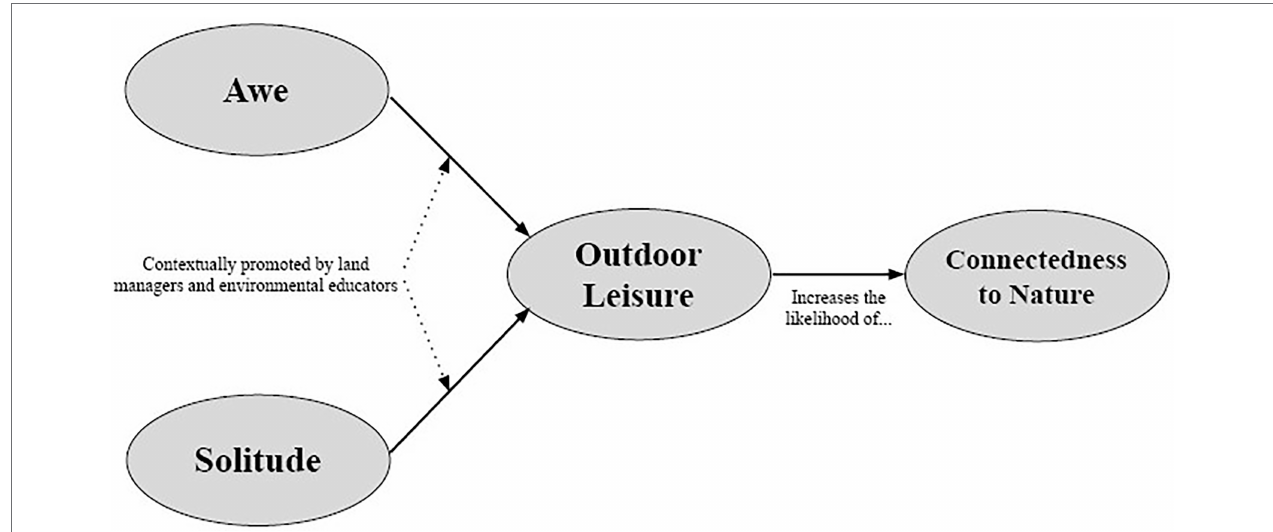
FIGURE 1 | The proposed framework outlining the relationship between awe, solitude, outdoor leisure, and connectedness to nature in urban natural